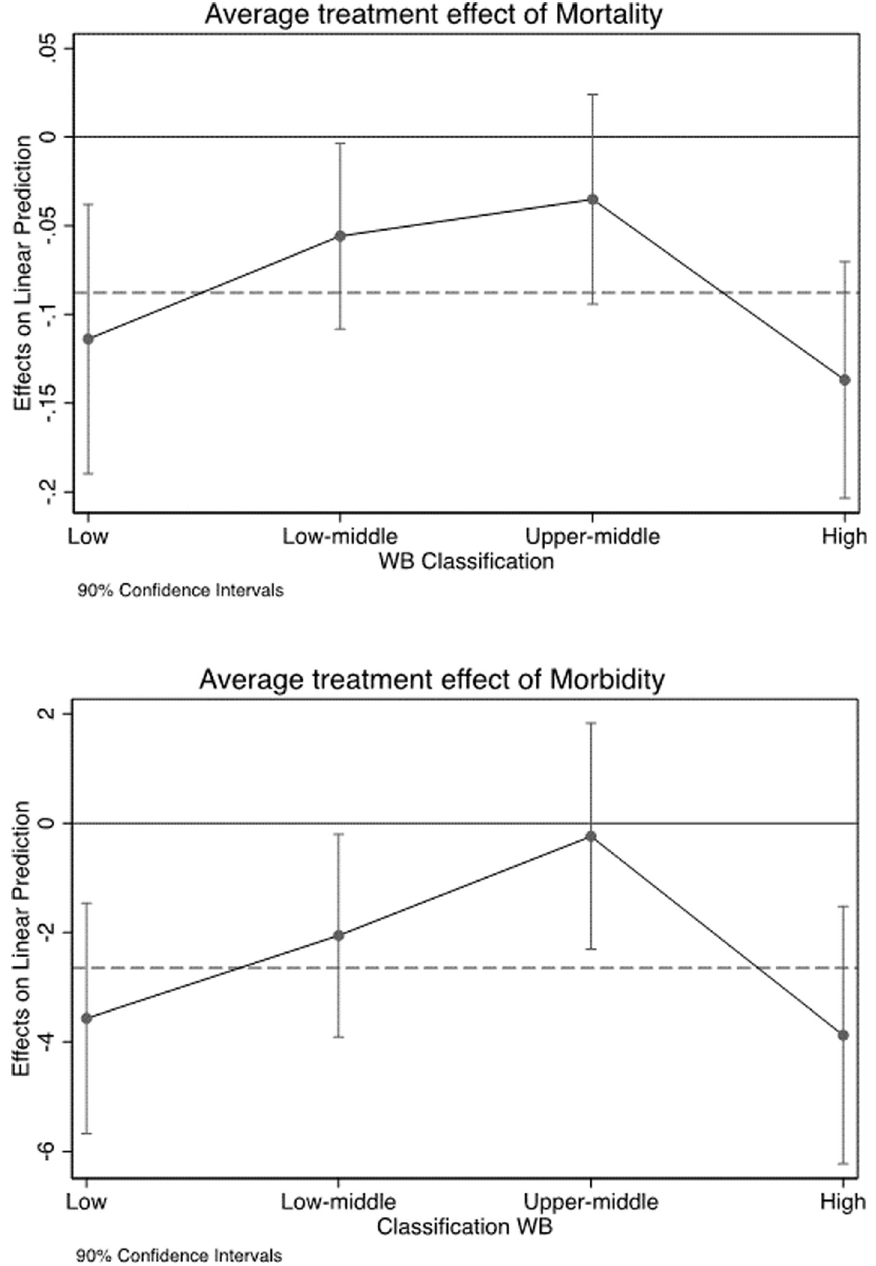
Fig 2. Heterogeneous effects by WB classification group. Note: Average treatment effects by WB classification group. Average treatment effects for the full sample (dotted